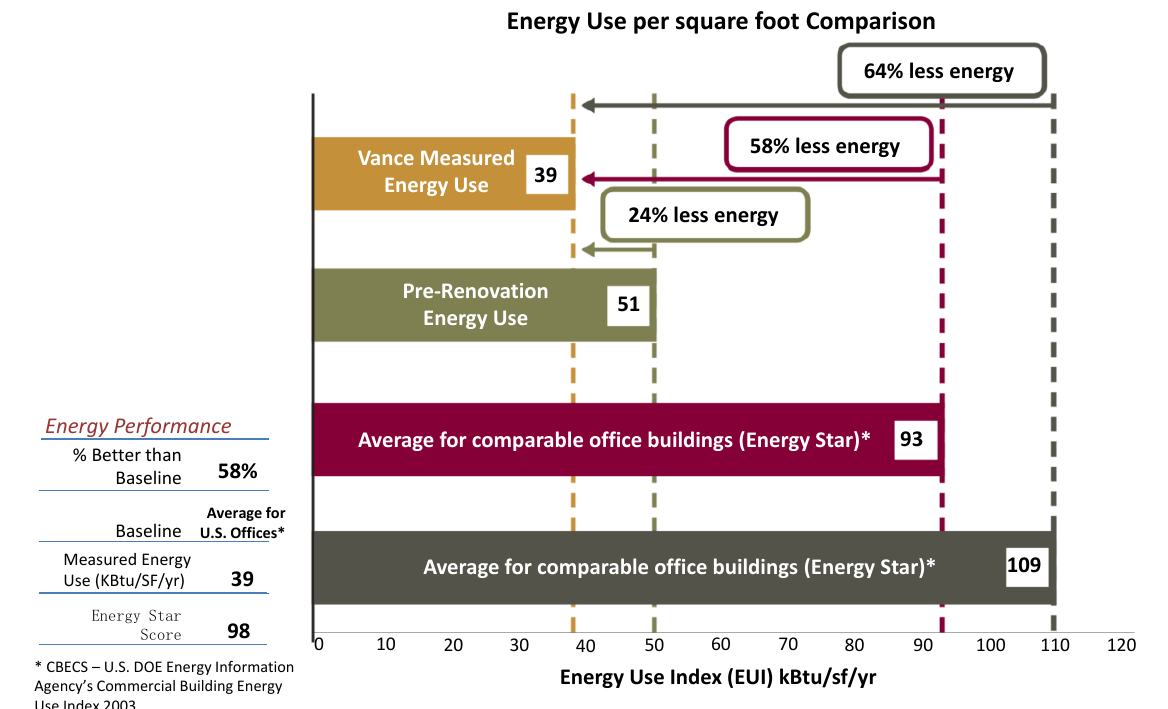
Figure 4. Gauging energy performance of the retrofitted Joseph Vance Building, Seattle, WA, USA (Diagram by author; redrawn from